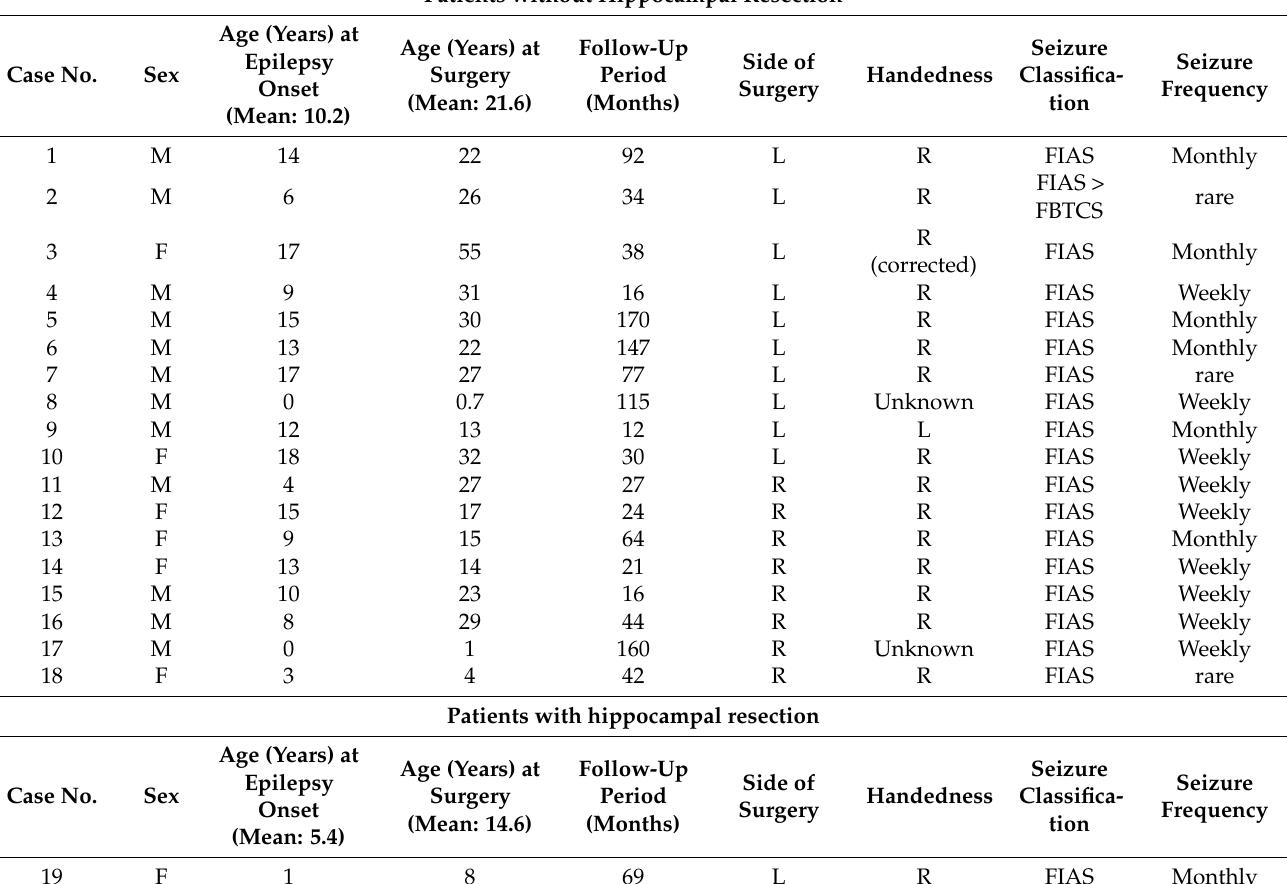
Table 1. Patient characteristics.